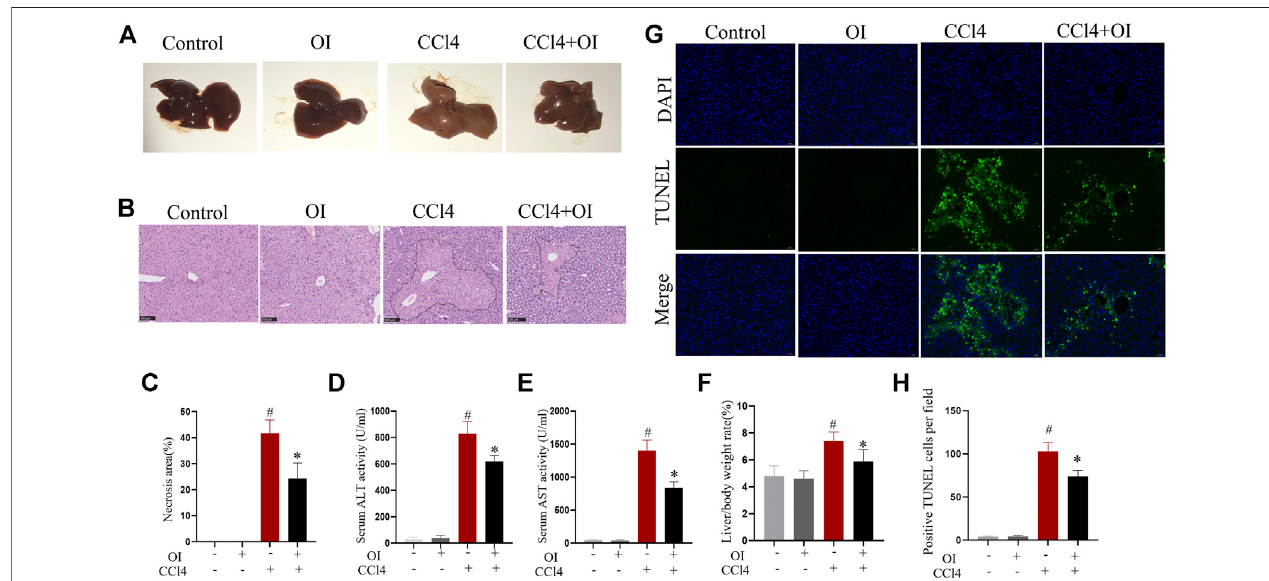
FIGURE 1 | Effect of OI on CCl4-induced hepatic injury in mice. (A) Representative photographs of the whole liver were taken 24 h after CCl4 treatment. (B) Representative HE staining hepatic images of each group. The black border indicated the necrosis area. (C) The necrosis area was measured based on H&E hepatic sections fromeach group. (D,E) Serum ALTand ASTlevels ofeach group. (F) Theliver/bodyweight ofeach group. (G) RepresentativeTUNELstaininghepatic sections for necrotic cells in each group. (H) The quanti fi cation of positive TUNEL cells per fi eld. Positive cells were counted in fi ve visual fi elds per liver section from each group. Original magni fi cation, × 200. Data are expressed as the mean ± SEM ( n (cid:1) 5 for each group); # p < 0.05 vs. control group; * p < 0.05 vs. CCl4-treated